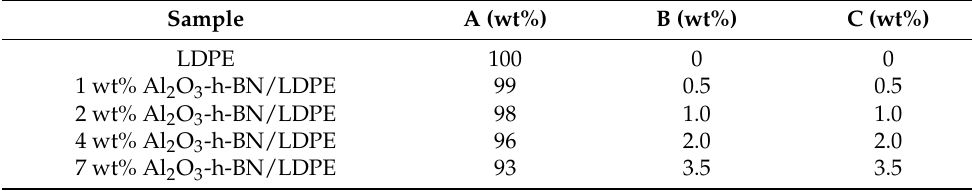
Table 1. The composition ratio of composite